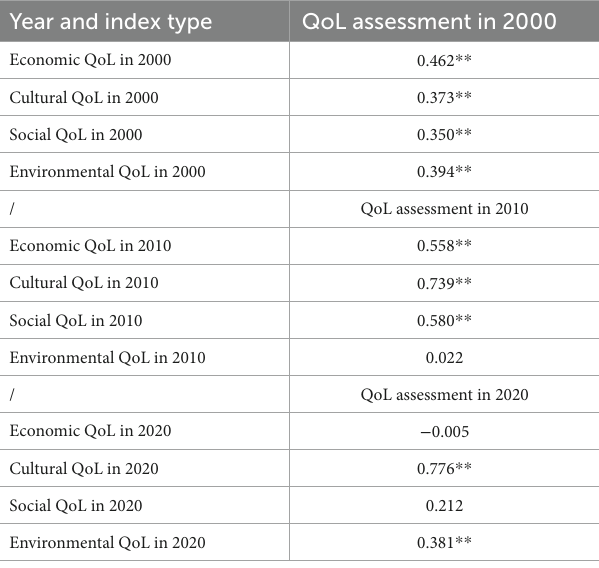
TABLE 4 The Global Moran’s I s, z -scores, and value of p s of QoL across the